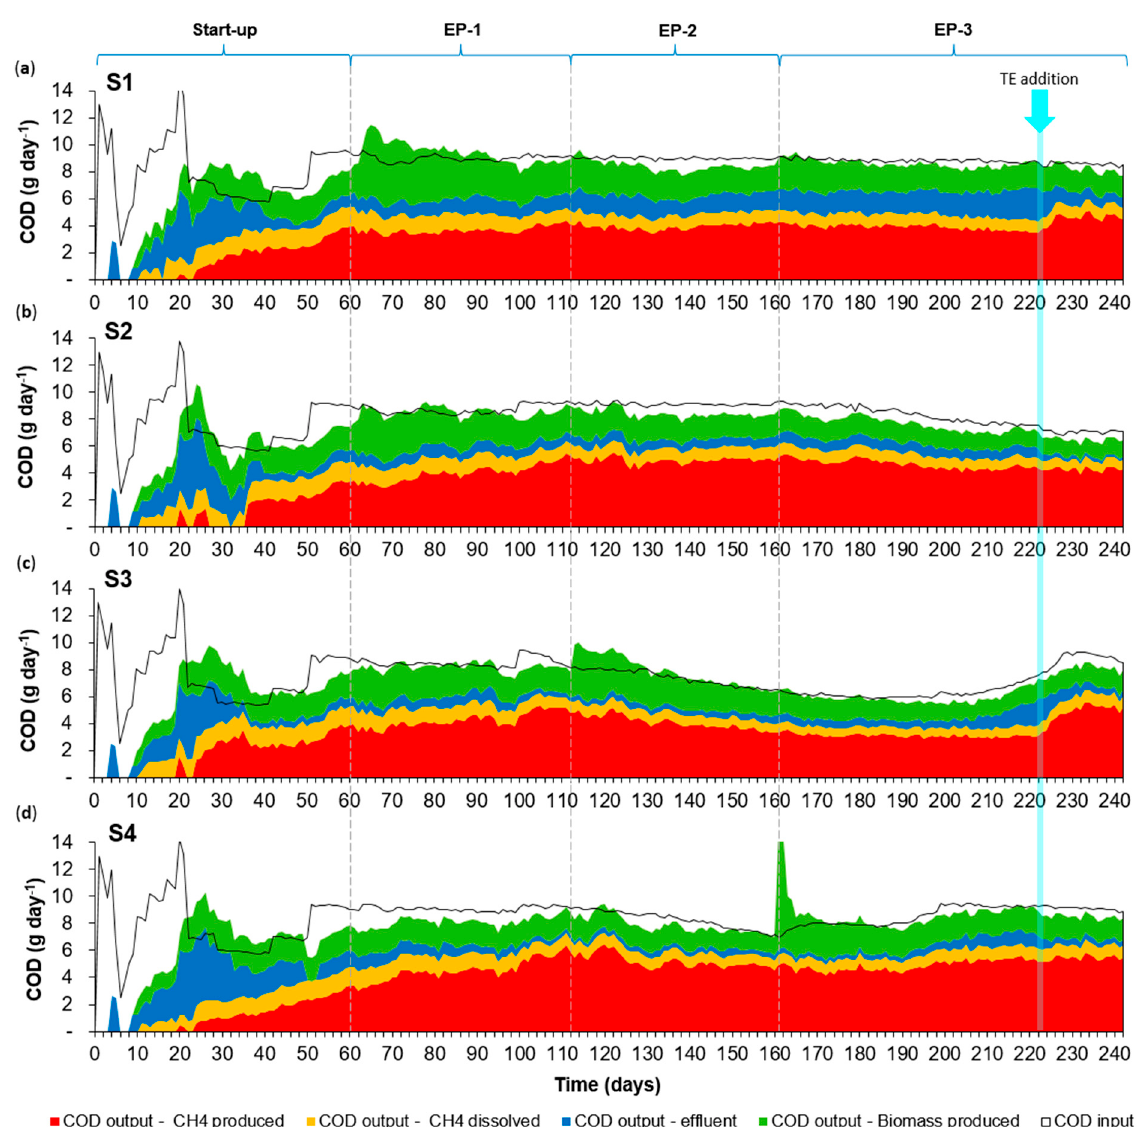
Figure 3. COD balances in SAnMBRs during the whole experimental period: ( a ) S1, ( b ) S2, ( c ) S3 and ( d ) S4. Vertical dotted lines indicate the start of experimental phases. Values for control parameters (SRT and TMP) in each phase are shown in Figure 2 and Table A2.